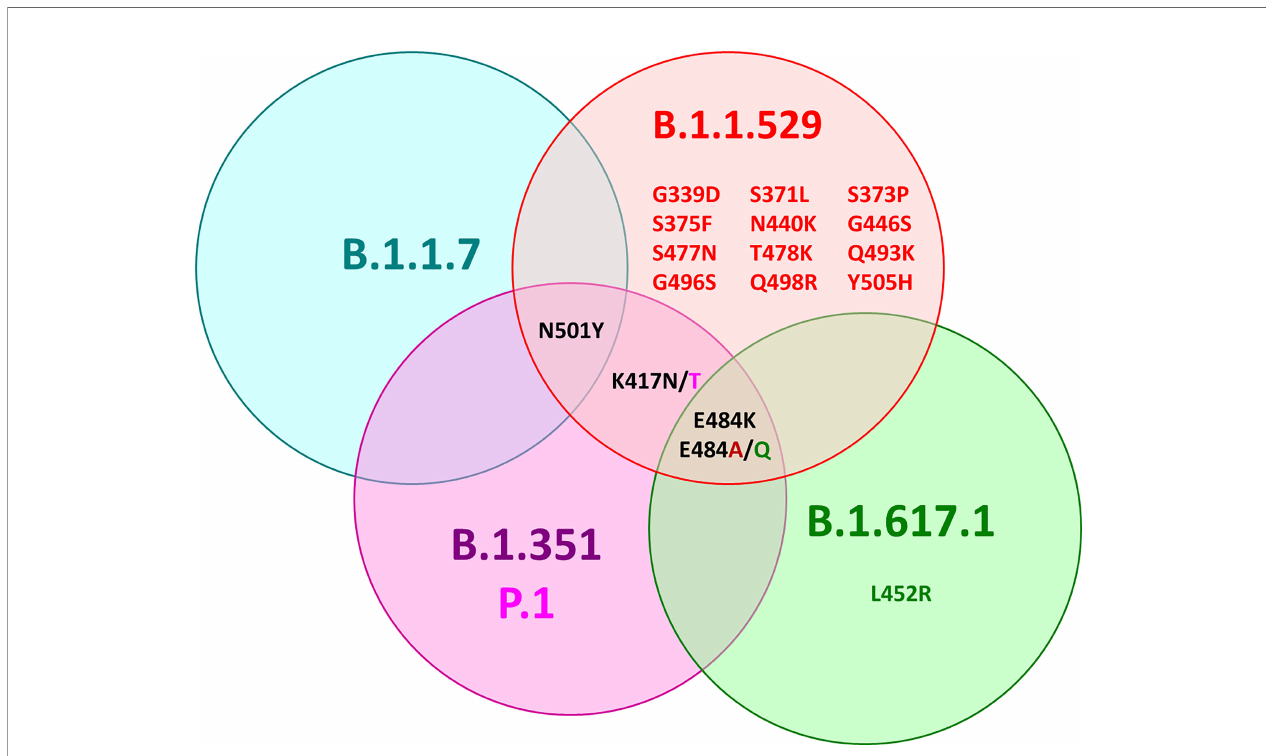
FIGURE 1 | Venn diagram of the mutation sites in the RBDs of alpha (B.1.1.7, blue), beta (B.1.351, purple), gamma (B.1.351 P1, pink), delta (B.1.617.1, green), and omicron SARS-CoV-2 (B.1.1.529, red) compared to wild-type SARS-CoV-2 (Wuhan variant). Black font color indicates mutations shared by several variants, while mutations speci fi c for one variant are indicated by the corresponding font